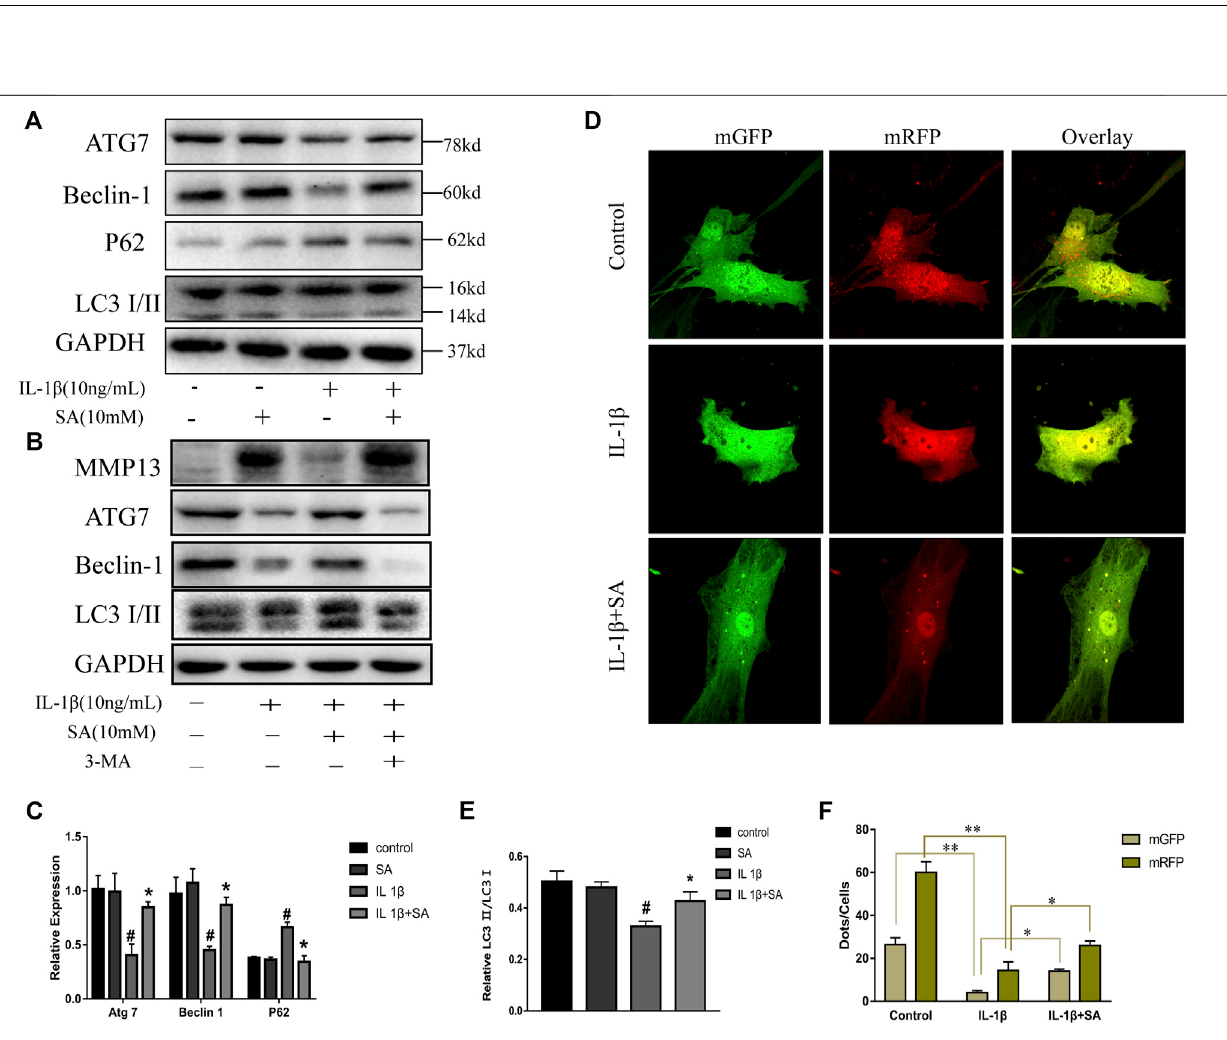
FIGURE4| SAamelioratesIL-1 β -inducedimpairmentofautophagyinSW1353cells. (A,C,E) Representativewesternblotsandquanti fi cationdatashowingATG7, Beclin-1,P62andLC3expressionincellstreatedasdescribedabove.Thedataareshownasthemean ± SD( n (cid:2) 3). # p < 0.05vs.thecontrolgroup;** p < 0.01vs.theIL- 1 β group. (B) Western blot showing the MMP13, ATG7, Beclin-1, and LC3 expression in cells treated as described above. (D,F) Fluorescence microscopy analysis of chondrocytes transfected in each group with mRFP-GFP-LC3-carrying adenovirus. The data are shown as the mean ± SD ( n (cid:2) 3). Signi fi cant differences between groups are indicated as ** p < 0.01, * p < 0.05.